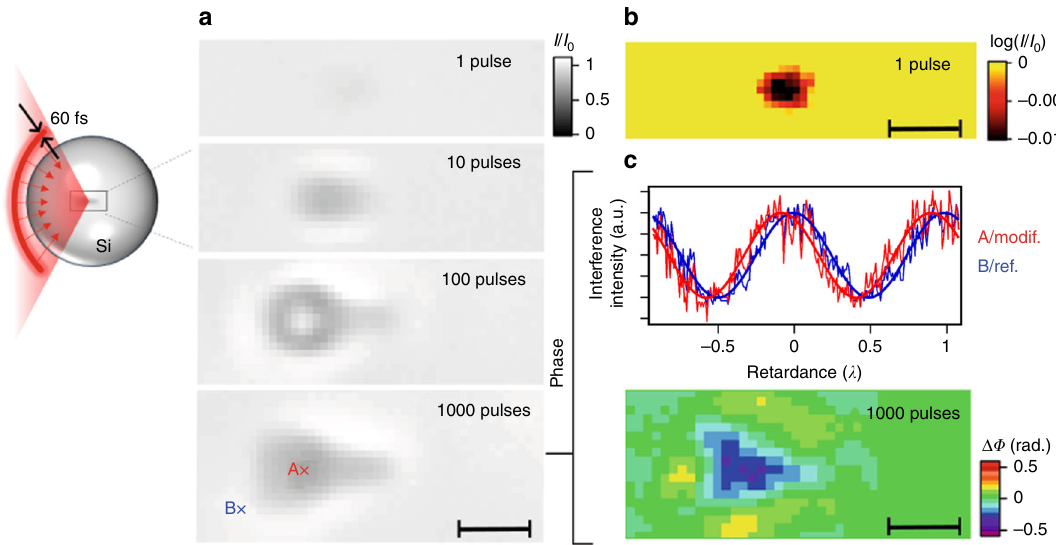
Fig. 3 Refractive index modi fi cation achieved in the bulk of silicon with ultrashort pulses. Micro-modi fi cations are created at the centre of silicon spheres using focused 60-fs laser pulses with the hyper-NA value of 2.97 (illustrated by the sketch) and then analyzed by infrared microscopy. a Bright- fi eld infrared images of modi fi cations for different number of applied laser pulses. b Transmission image in logarithmic scale revealing a modi fi cation after the fi rst applied laser shot. c Differential-longitudinal interferometry measurement (for two pixels A and B shown on the image for 1000 pulses) and corresponding phase image for the modi fi cation created with 1000 applied pulses. This indicates a local change of the silicon refractive index Δ n < − 0.07 after repeated illumination. ( scale bars : 2 µ